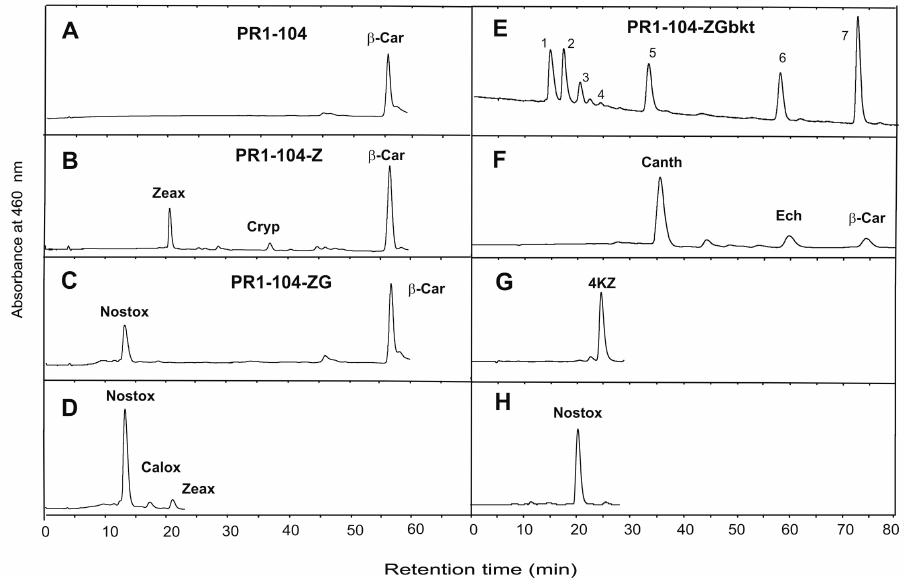
Figure 2. HPLC separation of hydroxy and keto carotenoids from Xanthophyllomyces dendrorhous lines obtained by consecutive transformation with different trans genes. Traces A – D separated in HPLC system I, E – H in system II. Standards are shown in traces D , F – H . Abbreviations (and assignment of corresponding peaks): β -Car β -carotene (7), Zeax zeaxanthin, Cryp β -cryptoxanthin, Nostox nostoxanthin (3), Calox caloxanthin, Canth canthaxanthin (5), Ech echinenone (6), 4KZ 4-keto-zeaxanthin (4).